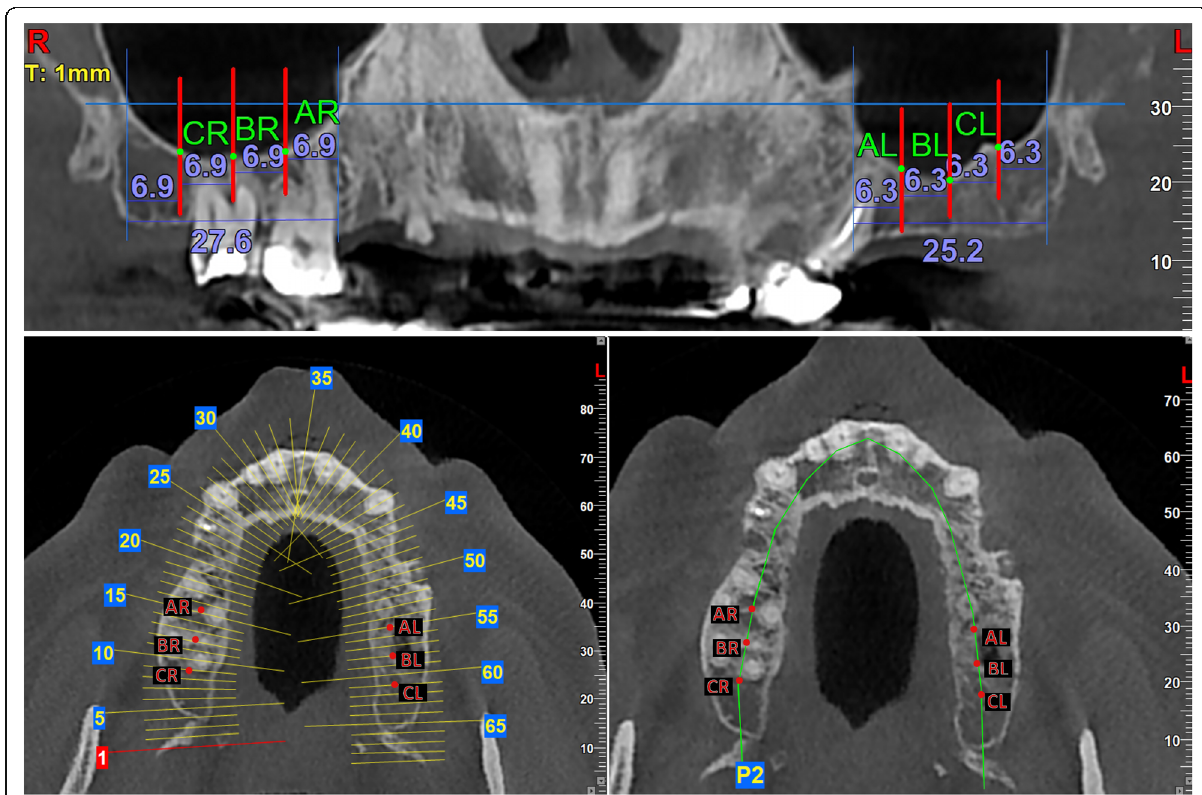
Fig. 1 Demonstration of the method used in the panoramic image to divide the sinus in four equal parts and find three fixed points for the measurements. Also, these fixed points in the horizontal plane with and without